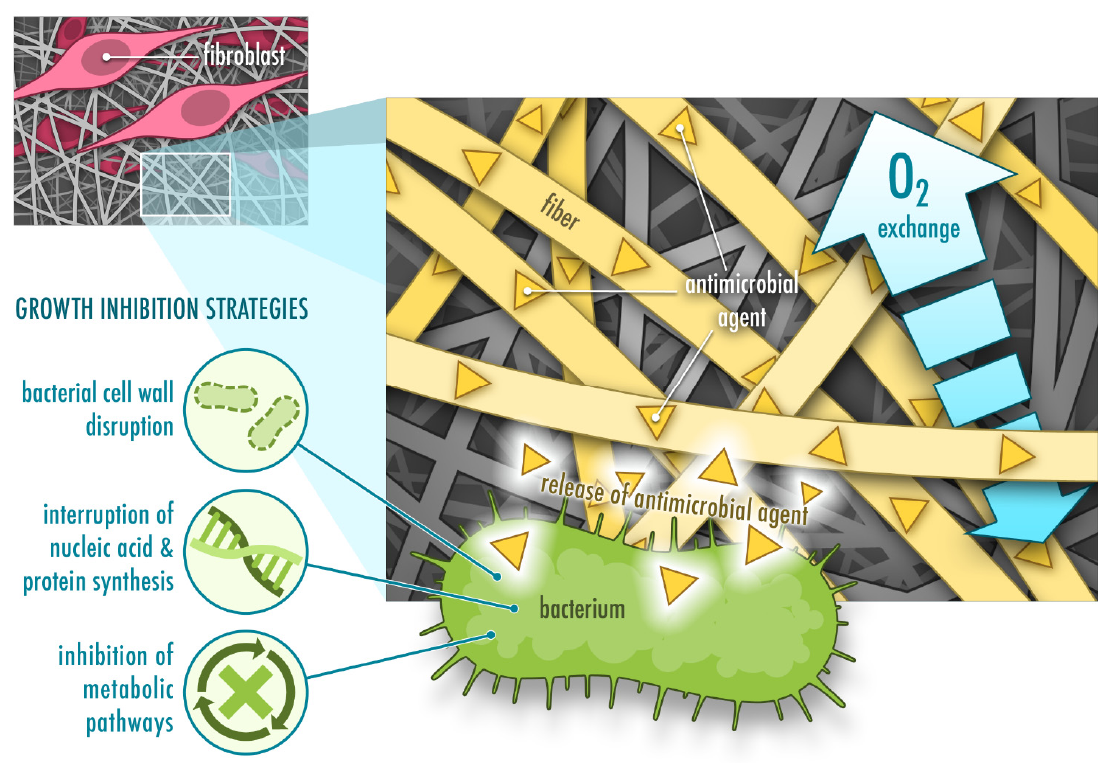
Figure 1. Functions of protein-based nanofibrous mats with incorporated antimicrobial agents for wound healing. They al- low fibroblast adhesion (often through cell-recognizing motifs the fiber carries), oxygen exchange and show bacteriostatic or bactericidal